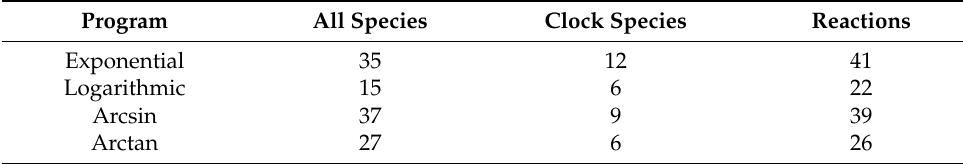
Table 4. Size of